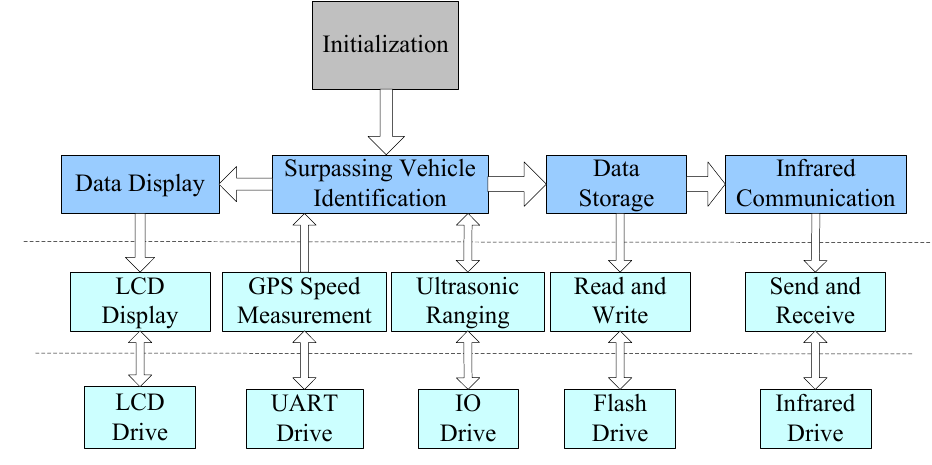
Figure 3. Schematic diagram of the system software